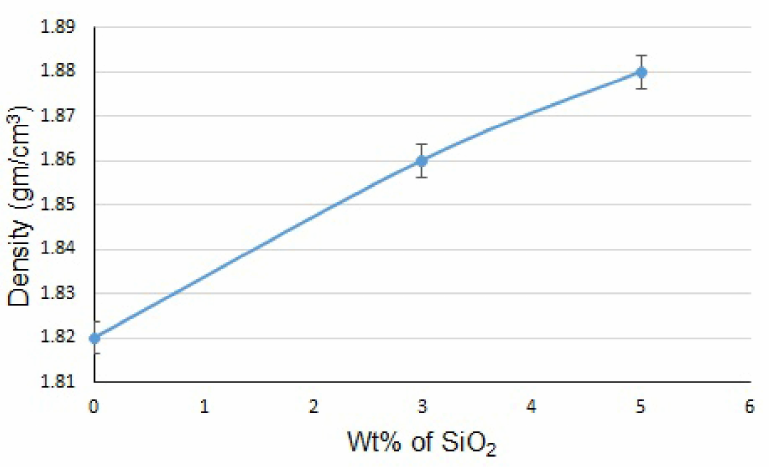
Figure 5. Density of Mg-based composite with different wt% of SiO 2